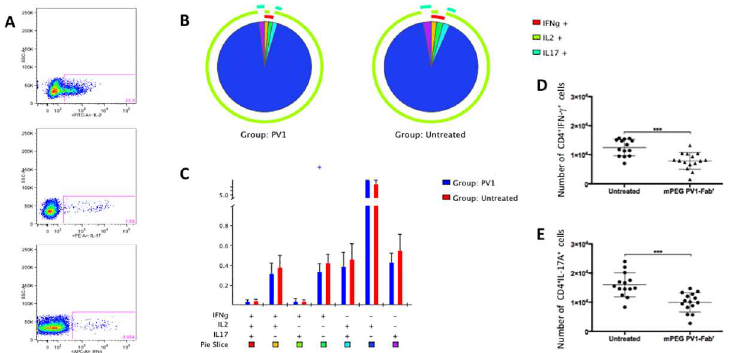
Fig 5. mPEG PV1-Fab’ dampens IFN- γ production by CD4 + T lymphocytes. B10.RIII mice were immunized with 50 μ g/animalof 161–180IRBP in CFA, plus 500 ng/animal of PTx boost. Starting on day 9, mice were treated every 4 days with CD28 antagonist, PV1 (10mg/Kg; ip), or left untreated. On day 14 mice were sacrificedand dLN were collectedfor immunophenotypingand evaluationof cytokine production.For the intracellular stainingof IFN- γ and IL-17 cells were collected from dLN (3 mice/group), plated at 1x10 6 cells/ well concentration and stimulatedovernightwith 100 ng/mL of PMA and 500 ng/mL of ionomycin, plus GolgiPlugat manufacturer’s recommended concentrations. (A) Representative plots show IFN- γ , IL-17 and IL-2 production by CD3 + CD4 + cells. (B) Pie charts (C) and absolute frequency of CD4 + IFN- γ + cells. In brief, each subpopulationdepictedin the bar graph is also depicted in the pie chart as pie slices, followingthe same color code. Overall IFN- γ , IL-17 and IL-2 production is displayedas the outer arcs in the pie charts. (D) Total numbers of CD4 + IFN- γ + cells. Mean ± SD are depicted in (C) and (D). ** , p < 0.01; *** , p < 0.0001, two-tailed Mann-Whitney